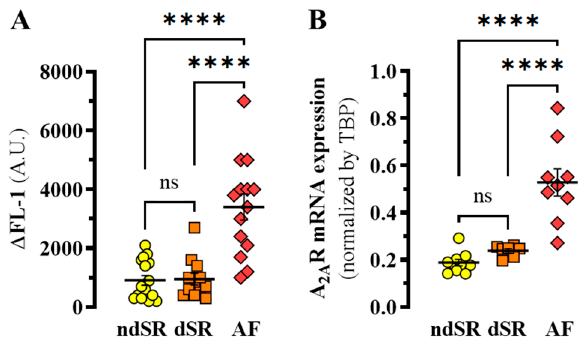
Figure 4. Detection of A 2A R in human PBMCs. ( A ) The specific MRS7396 binding to PBMCs from ndSR (yellow, n = 16), dSR (orange, n = 12) and AF (red, n = 14)) patients was obtained by subtracting the nonspecific binding (i.e., 100 nM MRS7396 in the presence of 100 nM of ZM241385) and represented as ∆ FL-1 (specific binding). ( B ) Relative expression of A 2A R mRNA in PMBCs. Mean ± SEM of ndSR ( n = 10), DSR ( n = 7) and AF ( n = 9) patients. **** p < 0.0001, one-way ANOVA with Tukey’s post-hoc test.